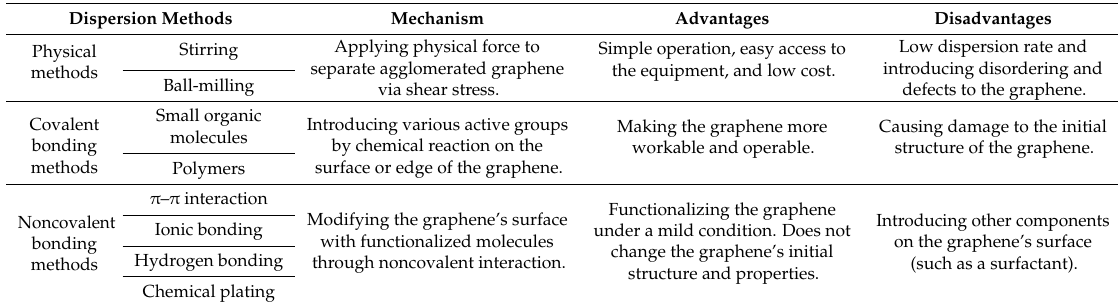
Table 1. The advantages and disadvantages of the physical methods, the covalent bonding methods, and the noncovalent bonding